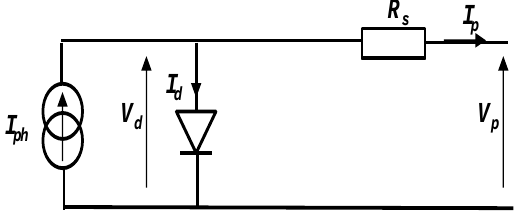
Figure 7. Single-diode electrical model (four parameters) of a PV cell.